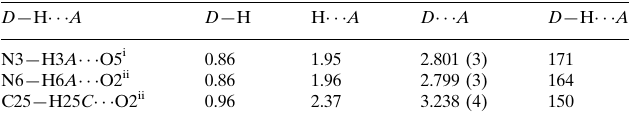
Hydrogen-bond geometry (A˚ , (cid:2)